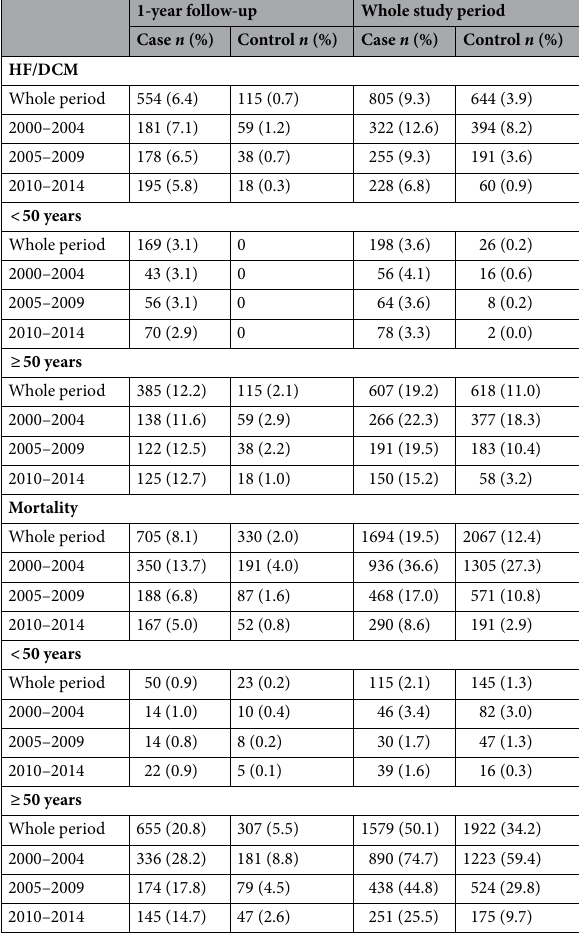
Table 2. Hospitalizations for heart failure/cardiomyopathy, and deaths during study period. HF heart failure, DCM dilated